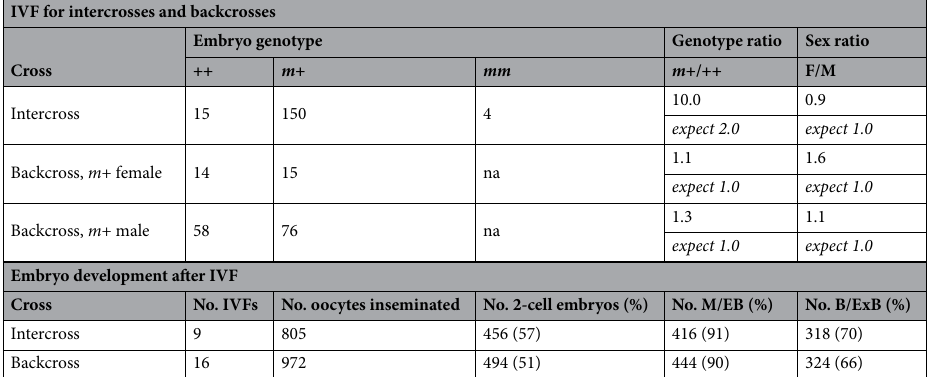
Table 1. In vitro fertilization (IVF) and embryo culture for intercrosses and backcrosses. For embryo development after IVF, the results for the reciprocal backcrosses were pooled. Percentage calculations: 2-cell embryos from inseminated oocytes; M/EB and B/ExB from 2-cell embryos. M, morulae; EB, early blastocysts; B, blastocysts; ExB, expanded